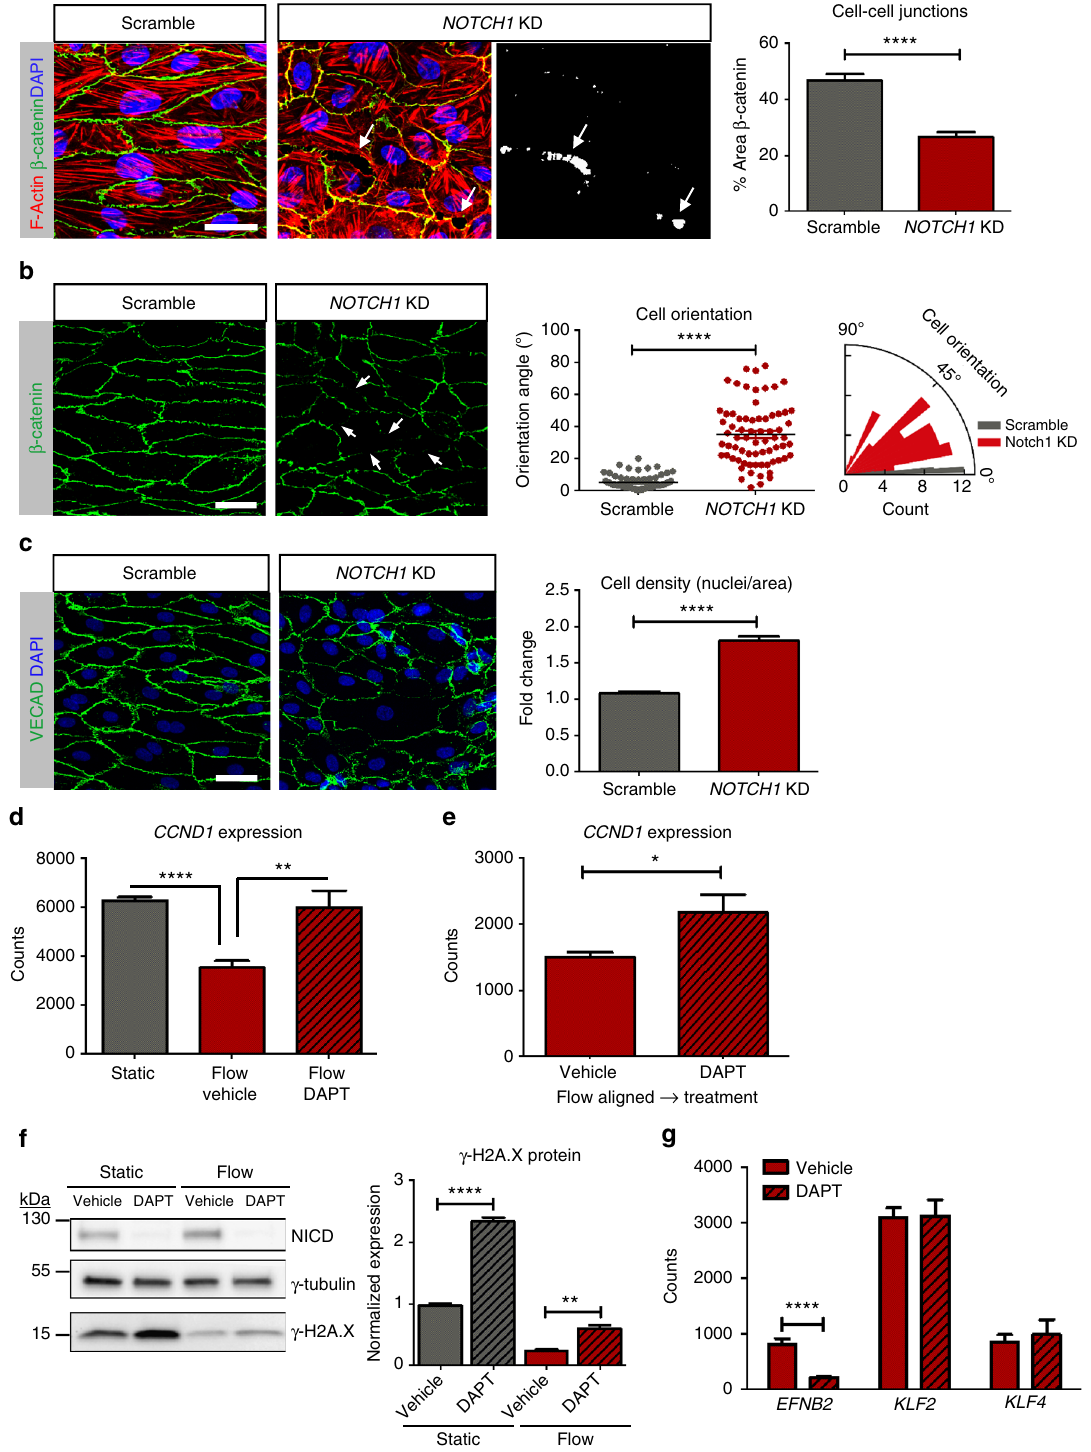
calcium-dependent pathways (Fig. 6a). Volcano plots of the data visualizes the differentially expressed genes in black with speci fi c cell cycle genes highlighted in red, in fl ammatory genes high- lighted in orange, and genes regulated by intracellular calcium in green (Fig. 6b – d; Supplementary Tables 1 – 3 lists highlighted genes). NFATs are a family of calcium-dependent transcription factors that are stimulated by a rise in cytoplasmic Ca 2+ and the translocation of NFAT proteins to the nucleus requires